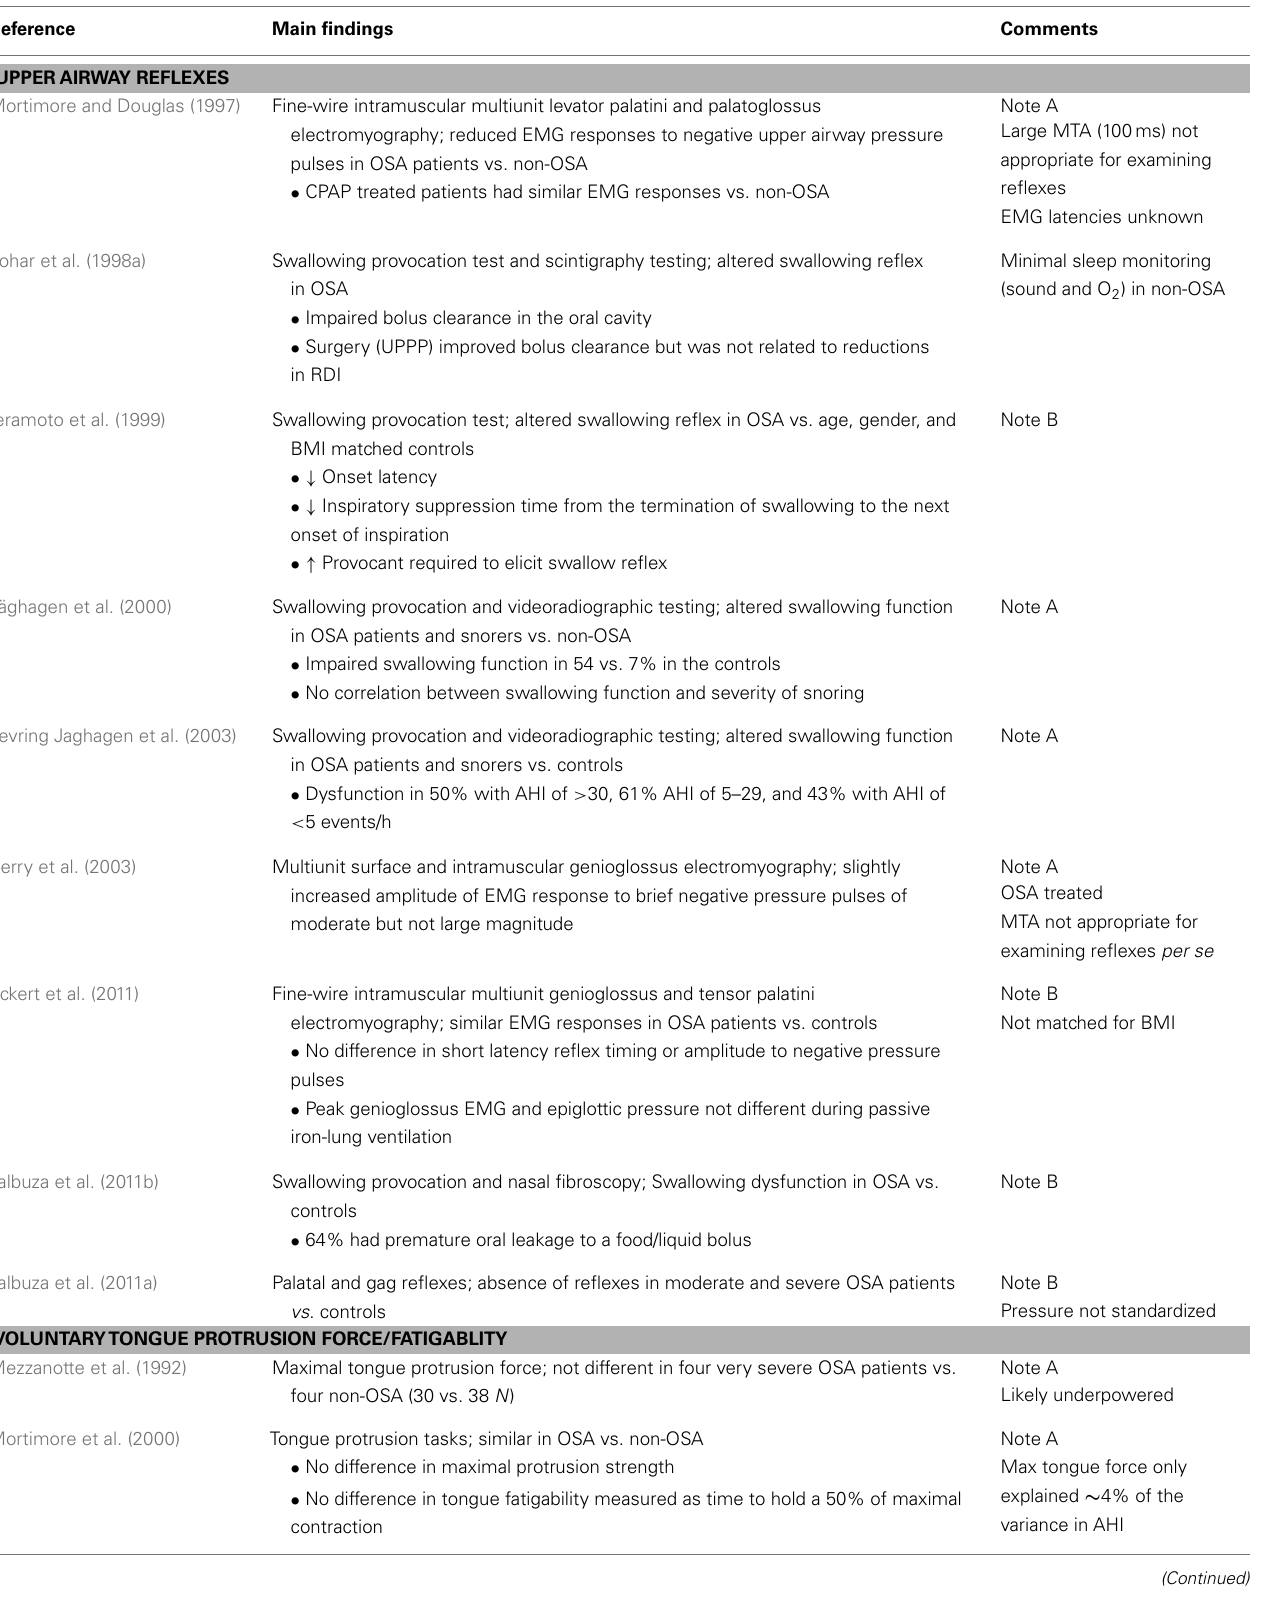
Table 5 | Functional